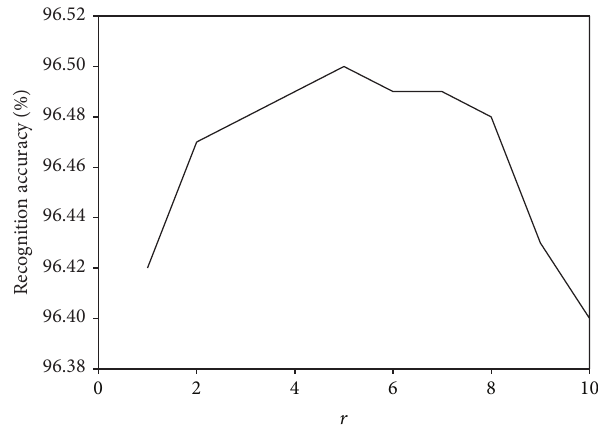
Figure 15: Recognition accuracy of MDGPP versus varying param- eter 𝑟 on the JAFFE